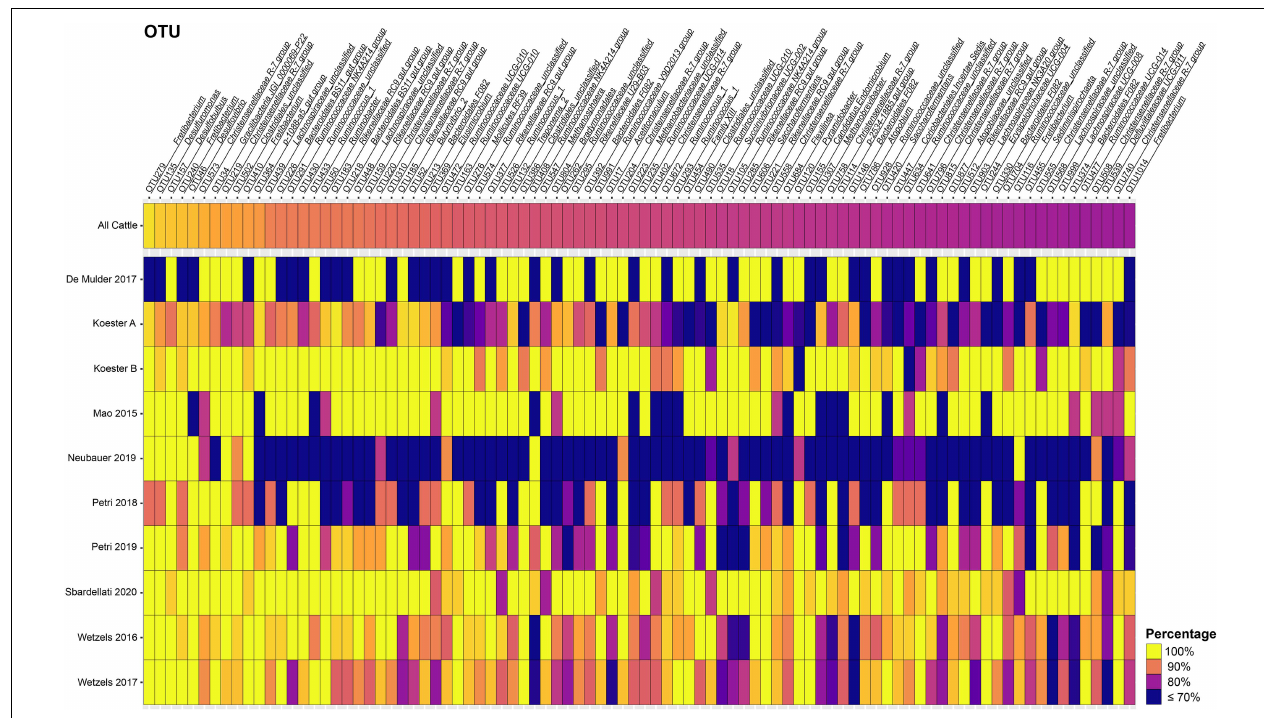
FIGURE 3 | Heat map of the 90 additional core rumen epithelial OTUs identified considering only cattle samples. Only OTUs present in ≥ 80% of cattle samples after closed-reference clustering and not included in the 57 core OTUs shared among all studies presented in Figure 2 are shown. The color represents the percentage of samples in a cattle study that contain the respective OTU. The percentage across all cattle samples is represented at the top. Values less than 70% have been truncated to 70% for greater resolution of the high values. See Supplementary Table 3 for more information about the cattle core rumen epithelial